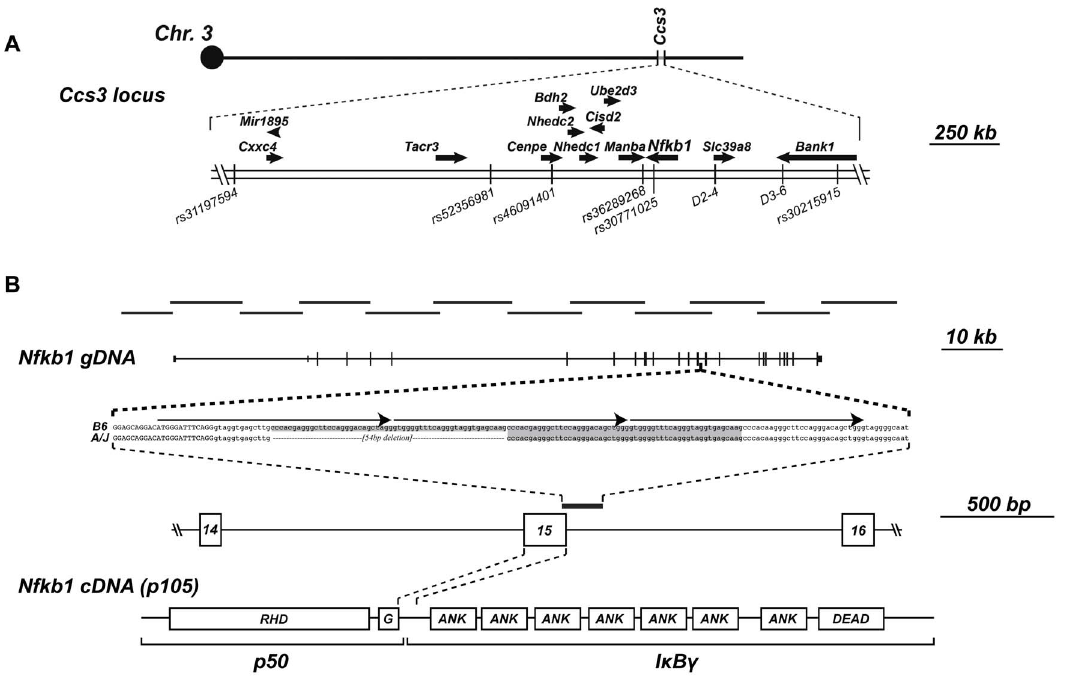
Figure 3. Positional candidate gene analysis of the Ccs3 locus. A . The Ccs3 locus contains 12 annotated transcripts, which position, direction of transcription (arrow), and position of reference SNP markers are shown. B . The position of long range amplification products used for deep sequencing of Nf k b1 is shown to scale along with the position of the 25 coding and non-coding exons of Nf k b1 . The position of the 54 bp intronic deletion identified in A/J is shown. It corresponds to the loss of a direct 54 bp repeat which is present in two copies in B6 (shaded in grey), which is itself composed of a 3-repeat structure (identified by arrows above the sequence). The position of the copy number variant with respect to exon 15 of the gene is shown, together with a projection of exon 15 translated sequence on predicted protein structure. Predicted p50 and I k B c portions of the protein are shown, along with the Rel homology domain (RHD), ankyrin-repeats (ANK), death domain (DEAD) and glycine-rich region (G) separating p50 and p105 (called I k B c